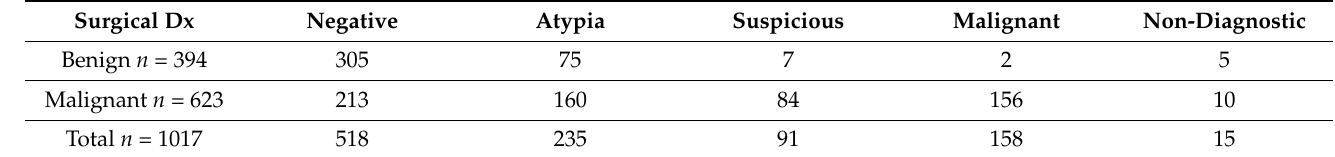
Table 1. Correlation of cytological subcategory diagnoses and final surgical pathology diagnoses. Surgical Dx